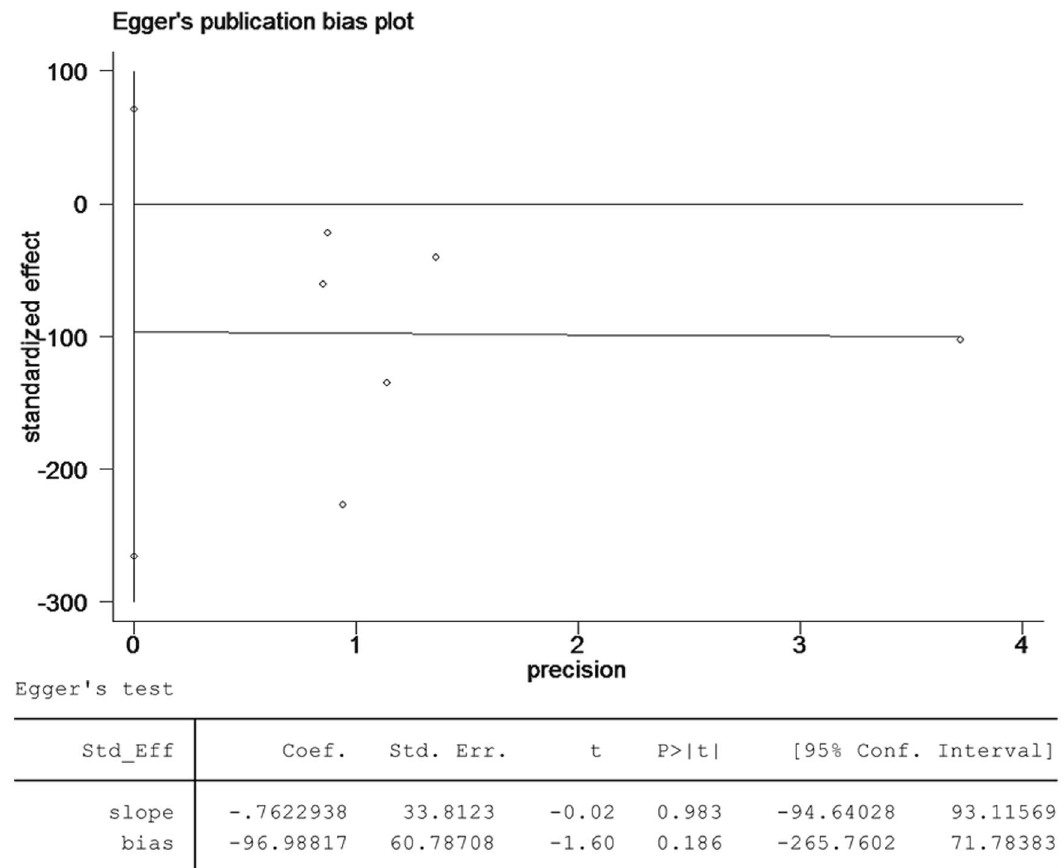
Fig 8. The Egger test for anastomotic leakage suggests that no publication bias is present in the pooled